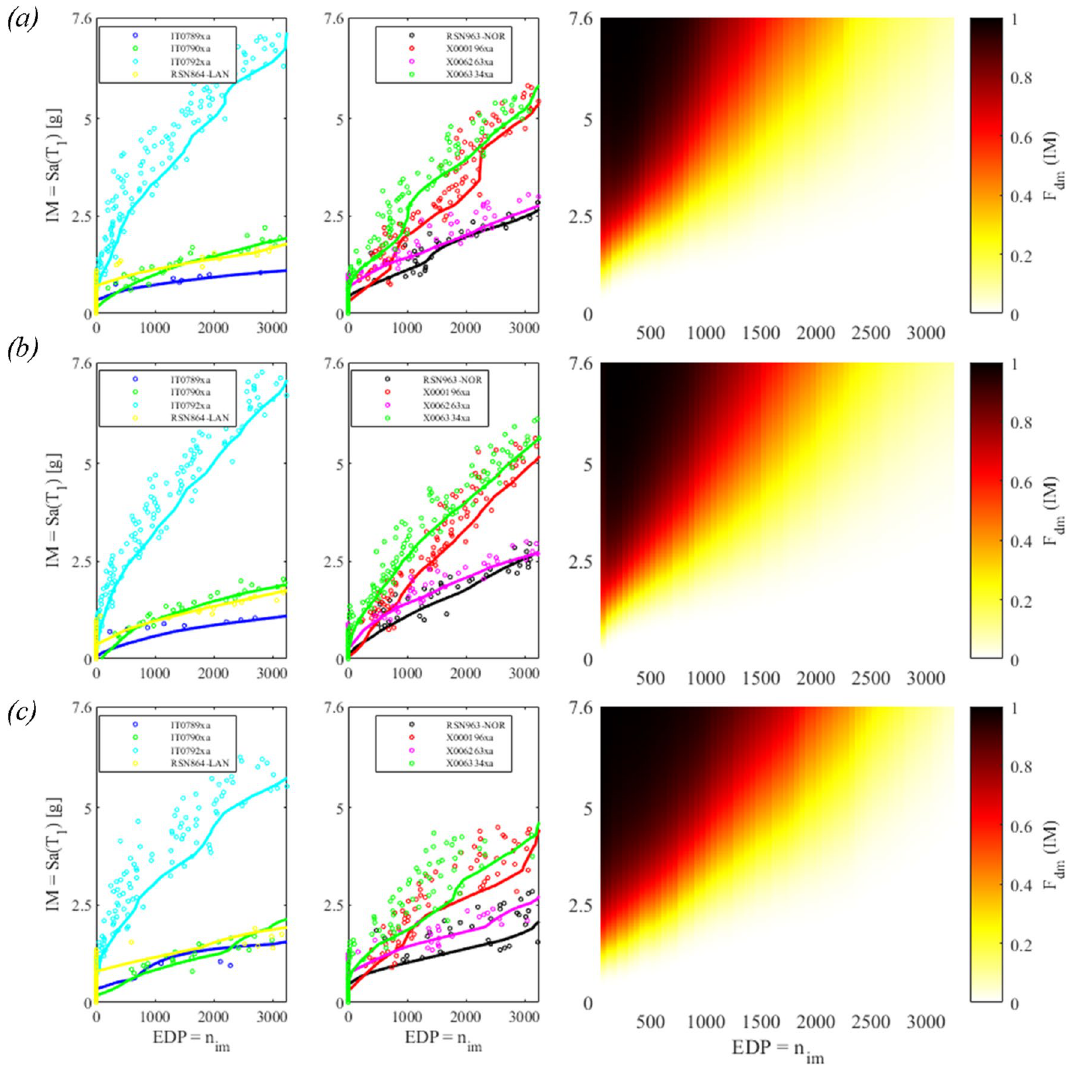
Figure 14. IDA curves on the left side and 2D color plot of the fragility function on the right side for: ( a ) the first optimal point with gap = 64 mm, COR = 0.49; ( b ) the second optimal point with gap = 58 mm, COR = 0.52; and ( c ) the third optimal point with gap = 80 mm, COR = 0.39. These optimal points are indicated by the circles in Fig.